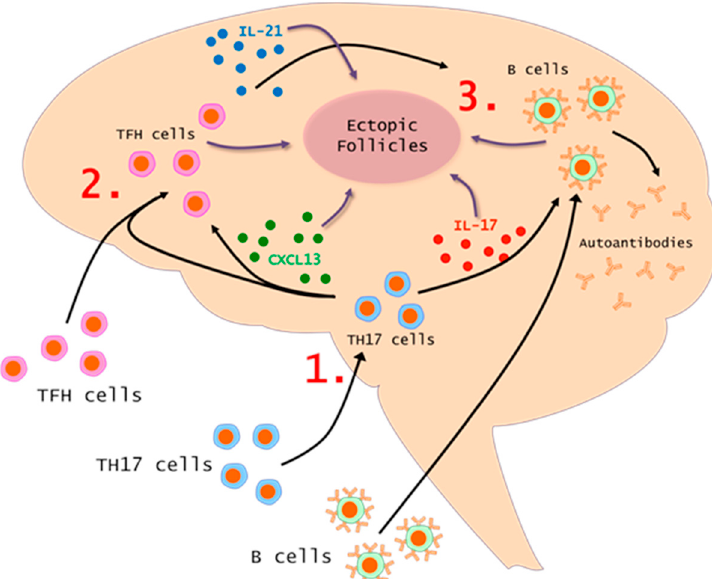
Figure 1. Model of Th17-TFH-B-cell Axis in MS. Th17 cells infiltrate the CNS, secrete IL-17, and induce inflammation. ( 1 ) Th17 responses drive the production of the chemokine CXCL13 which will facilitate